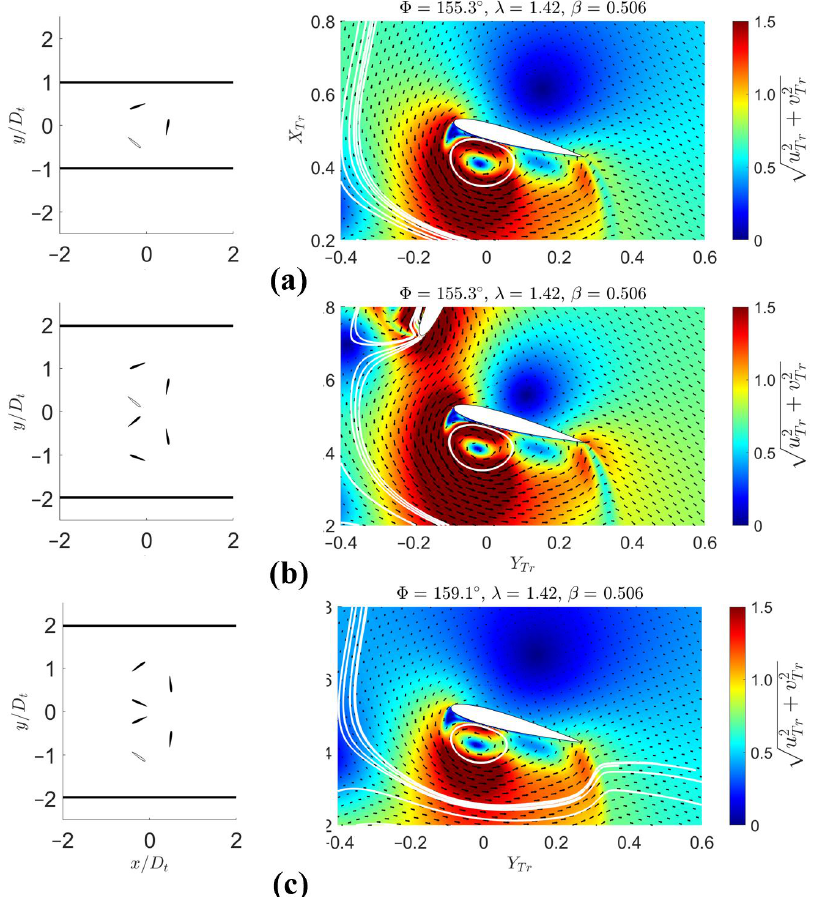
Figure 26. The velocity fields in the blade reference frame after it reached the maximum torque of the 3 configurations: single turbine ( a ), forward counter-rotating turbines ( b ), and backward counter-rotating turbines ( c ). On each figure, the lower surface is the turbine inner side and the upper surface is the turbine outer side. The figures on the left side show the position of the blade of interest colored in